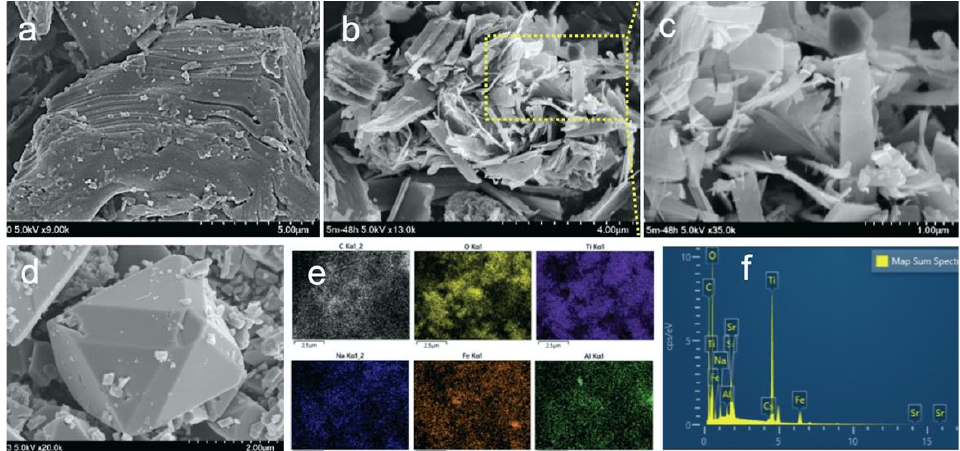
Figure 1. SEM image of ( a ) Ti 2 AlC MAX phase, and ( b , c ) magnetic M.Ti 2 CT x -A III nanostructures at different magnification, ( d ) Fe 3 O 4 magnetite, ( e ) elemental mapping of magnetic M.Ti 2 CT x -A III after